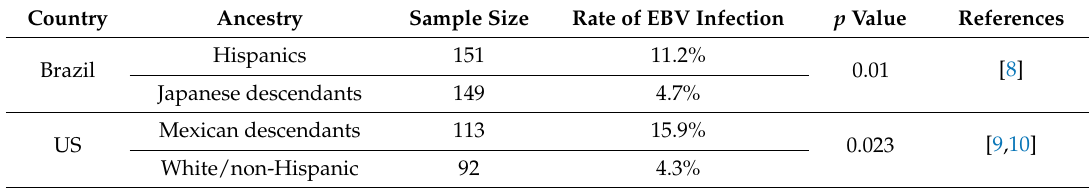
Table 1. Ancestry and Epstein-Barr virus-associated gastric cancer in the